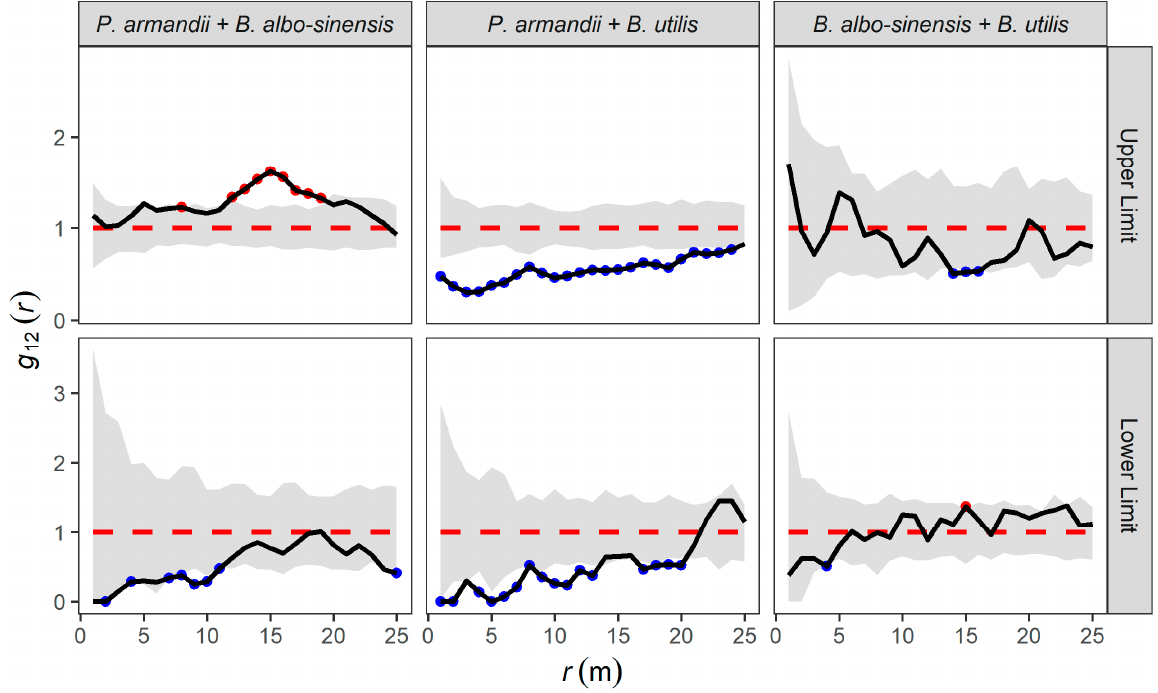
Figure 10. Correlation analysis of P . armandii , B . albo-sinensis , and B . utilis at the upper limit and lower limit of the treeline patch. Note: the red points are the g -values beyond the upper envelope at a corresponding scale, the blue points are the g -values under the lower envelope at a corresponding scale.